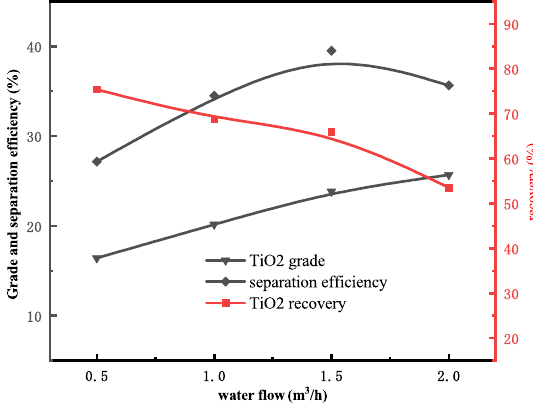
Figure 6. Effect of slope of water flow on